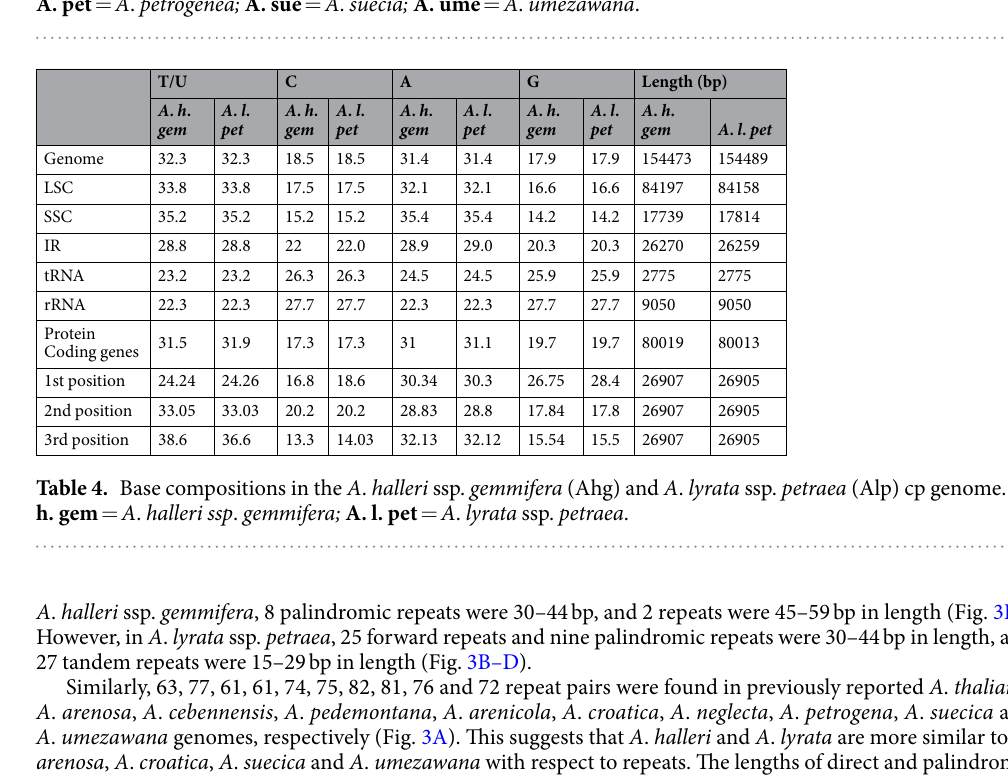
Table 3. Comparison of coding and non-coding region size among twelve Arabidopsis species. A. are = A . arenosa; A. ceb = A . cebennensis; A. h. gem = A . halleri ssp . gemmifera; A. l. pet = A . lyrata ssp. petraea; A. ped = A . pedemontana ; A. tha = A . thanliana; A. aren = A . arenicola; A. cro = A . croatica; A. neg = A . neglecta;